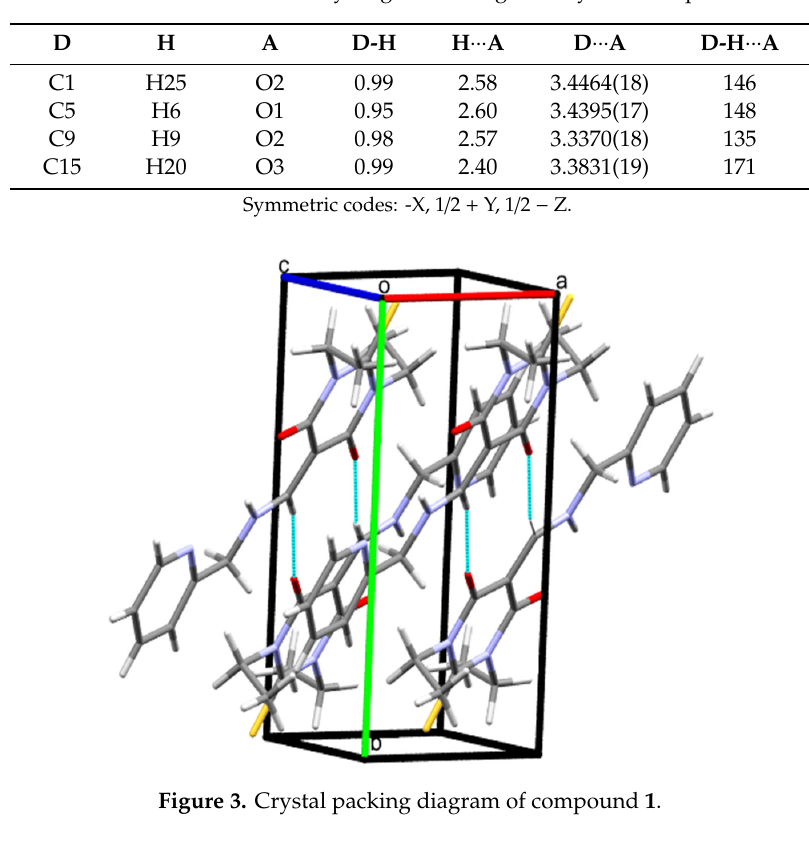
Table 2. The list of selected hydrogen bonds’ geometry Å in compound 1 .